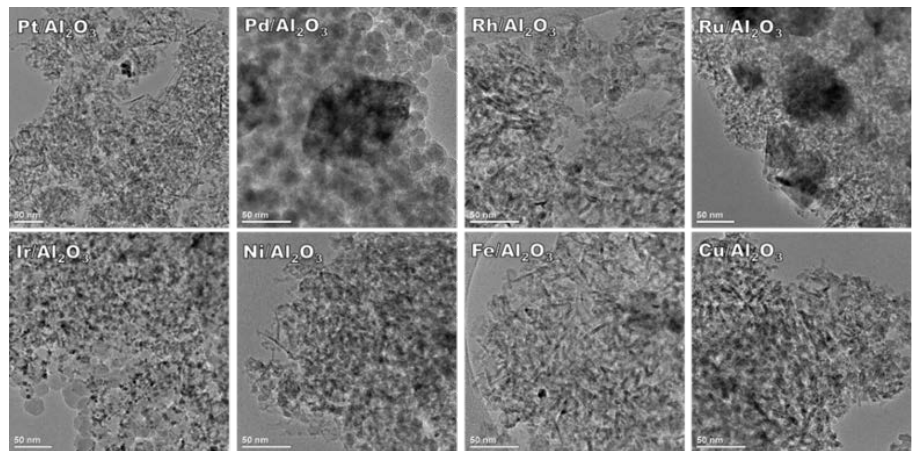
Figure 1. TEM micrographs of the different catalysts.